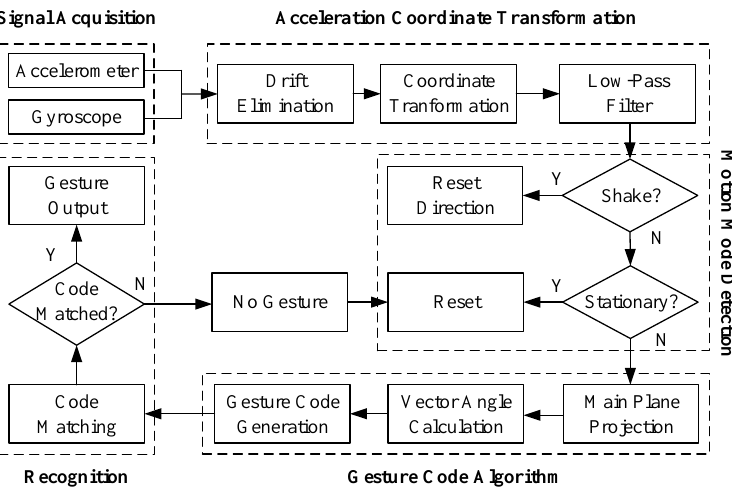
Figure 3. Block diagram of the axis-crossing code based gesture recognition algorithm.